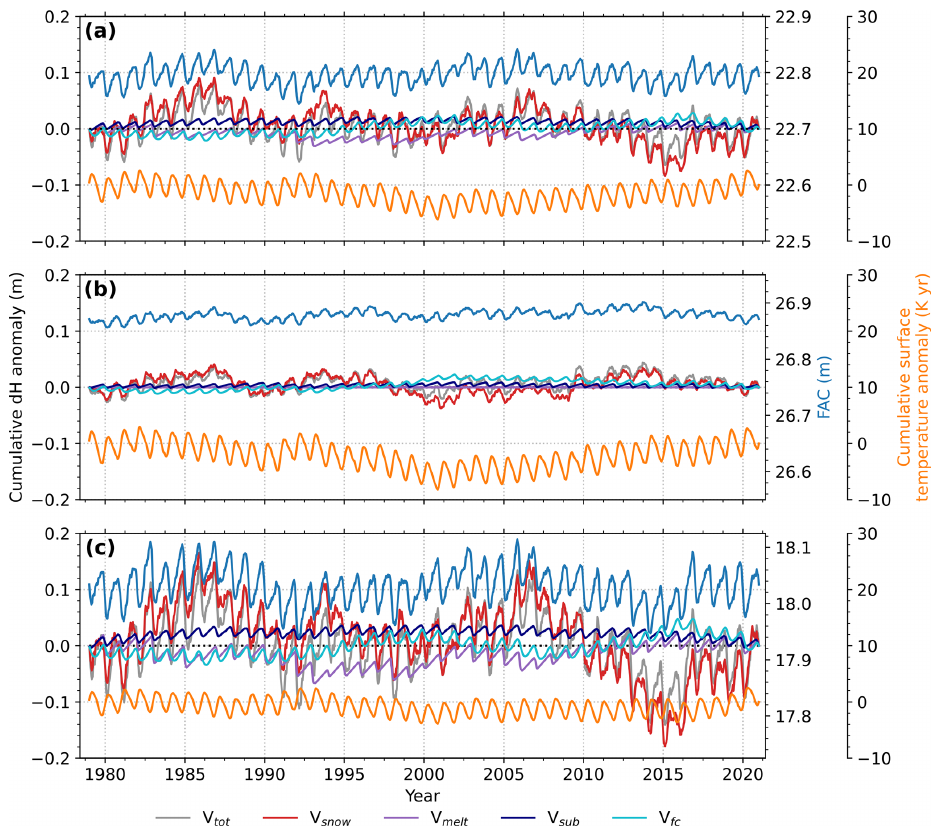
Figure 7. Time series from FDM v1.2A of FAC, the cumulative anomalies (against long-term mean) of surface temperature, the vertical firn surface velocity and its separate components from Eq. (6). Time series are shown for (a) the entire ice sheet, (b) the part of the ice sheet situated above 2000ma . s . l . and (c) the part of the ice sheet situated below 2000ma . s . l